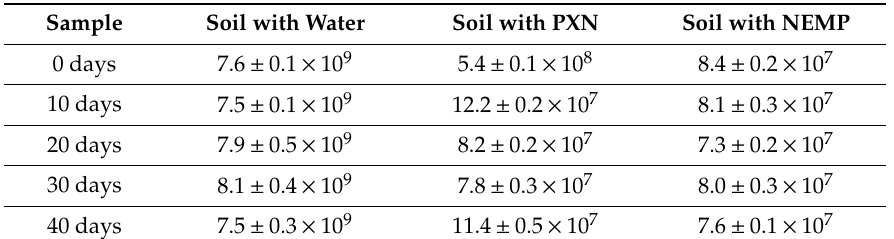
Table 3. Microbial viability of